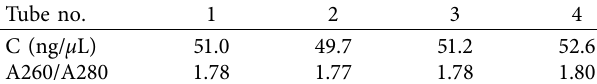
Table 1: The concentration and purity of genomic DNA of C. sakazakii . Tube no.